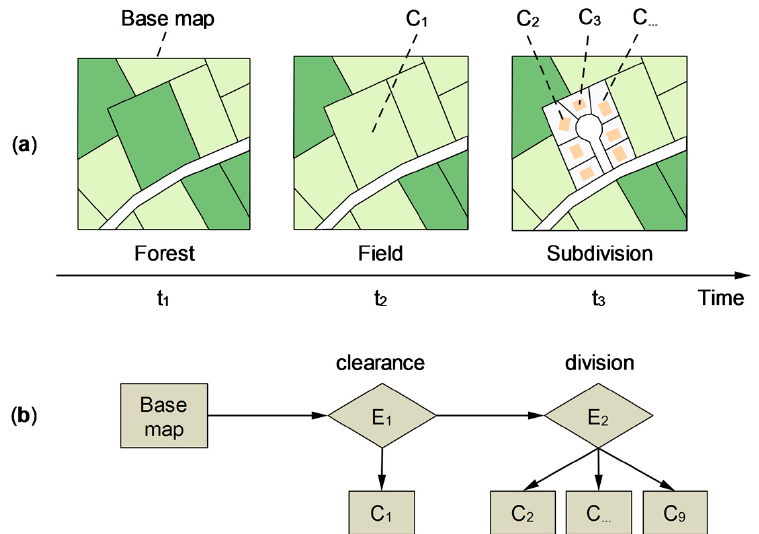
Figure 7. Land evolution illustrated with TEMPEST, ( a ) representation of the real-world entities, ( b ) geographic objects’ changes through a succession of events (diamonds) associated with lists of changes.